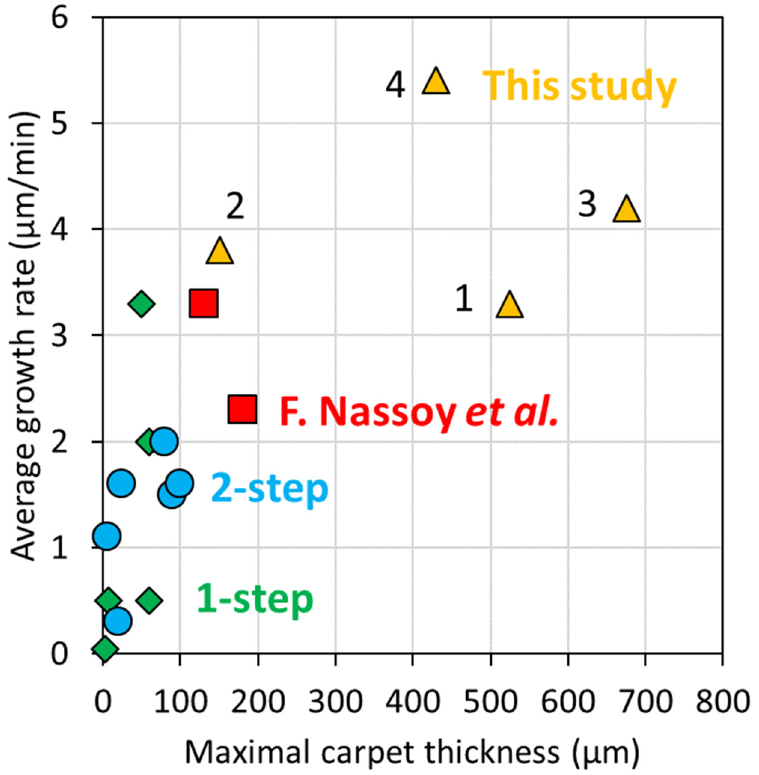
Figure 12. Average growth rate compared to maximal carpet thickness achieved, reported for low temperature one-step CVD process (green diamond), two-step CVD process (blue circles), and a study performed by F. Nassoy et al. (red squares). For comparison, present results obtained in our study are also shown (yellow triangles). Numbers indicate different synthesis conditions for VACNT growth, which are low acetylene content on low grade Al (1), high acetylene content on low grade Al (2), low acetylene content on high grade Al (3) and low acetylene content on high grade Al with enhanced Fe/C ratio of 0.8% (4).